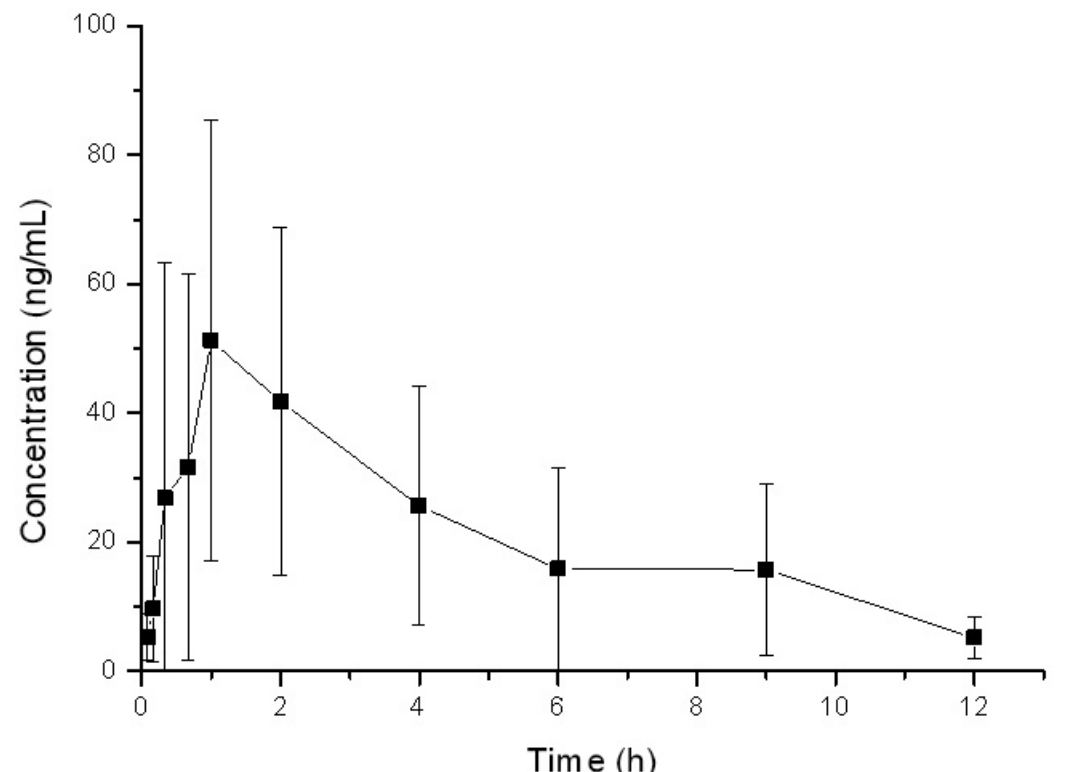
FIGURE 3 - Mean plasma concentration–time profile of lobetyolin in rats